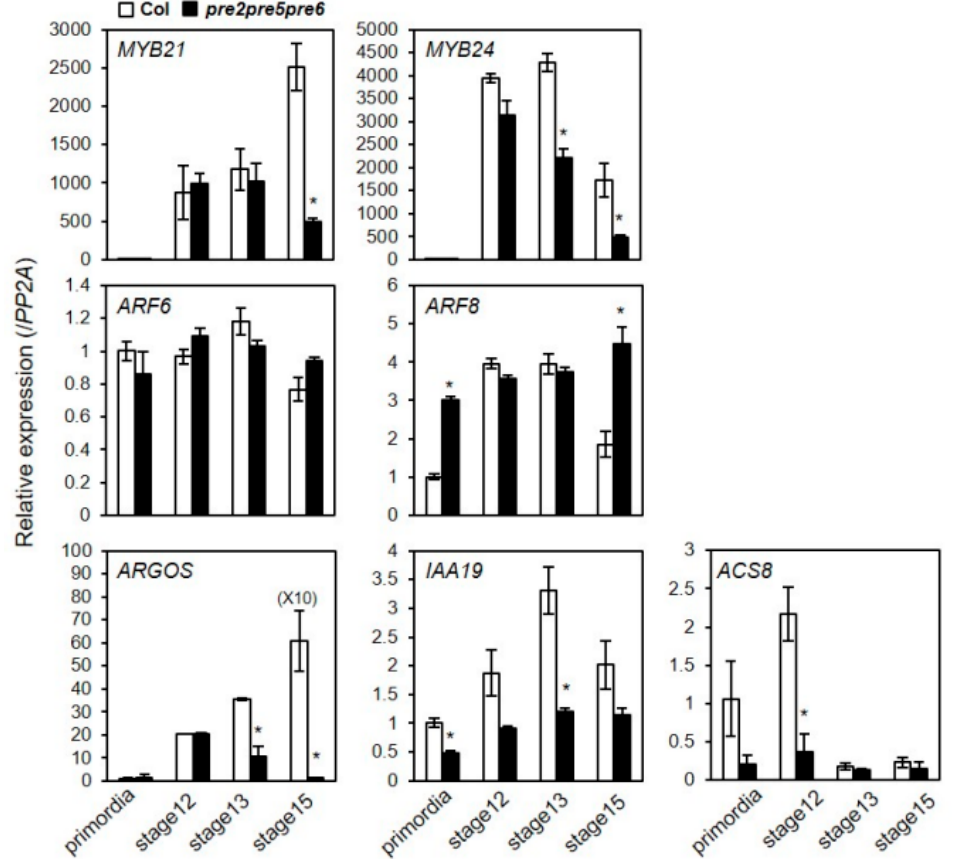
Figure 4. The expression of flower development-related genes was downregulated in pre2pre5pre6 flowers. Total RNAs were extracted from flowers at indicated flower developmental stages and relative transcript levels were examined by quantitative RT-PCR analysis. The PP2A gene was analyzed as an internal control. Values are mean ± SD from three technical replicates. Significant difference between wild type (Col) and pre2pre5pre6 is indicated with asterisk (t-test, * p < 0.01).